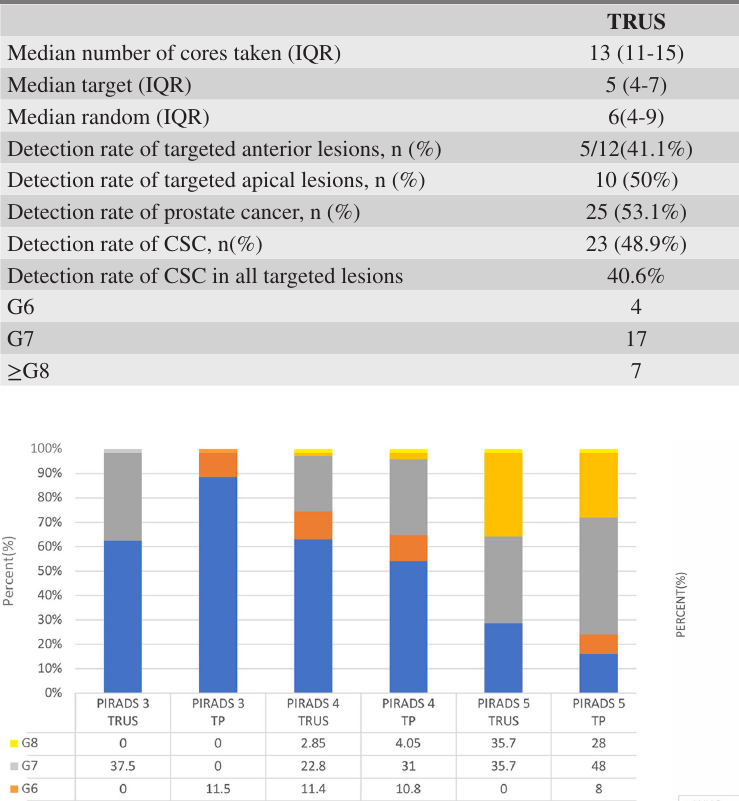
Table 2. Biopsy Results Including Prostate Cancer Detection Rate Stratified by Gleason, Number of Targeted and Random Cores as Well as Detection Rate of Apical and Anterior Lesions